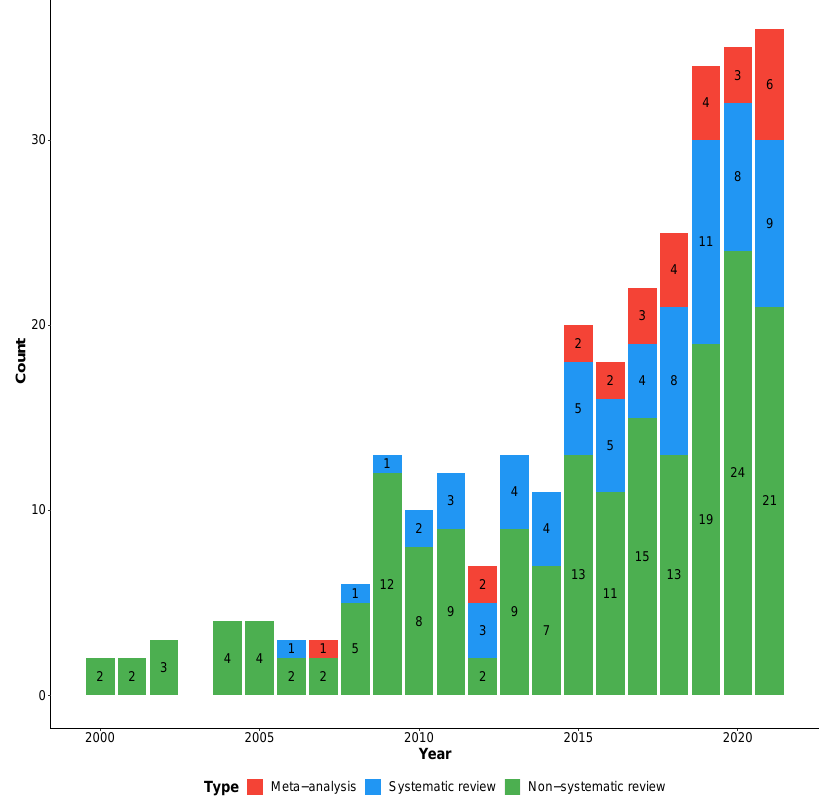
Figure 3. Type of review over the